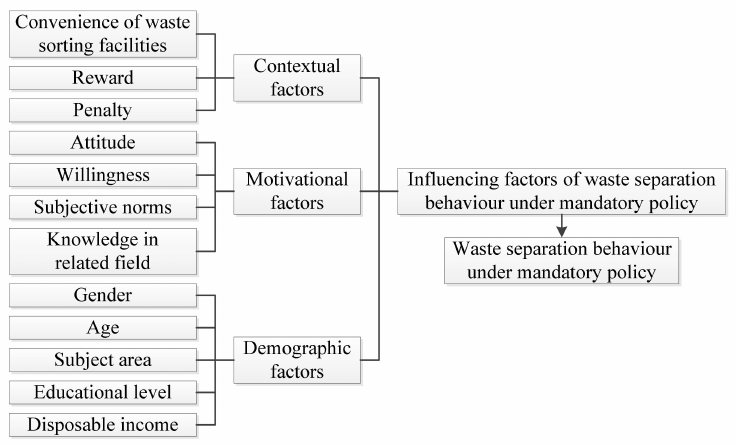
Figure 1. The model which underpins the